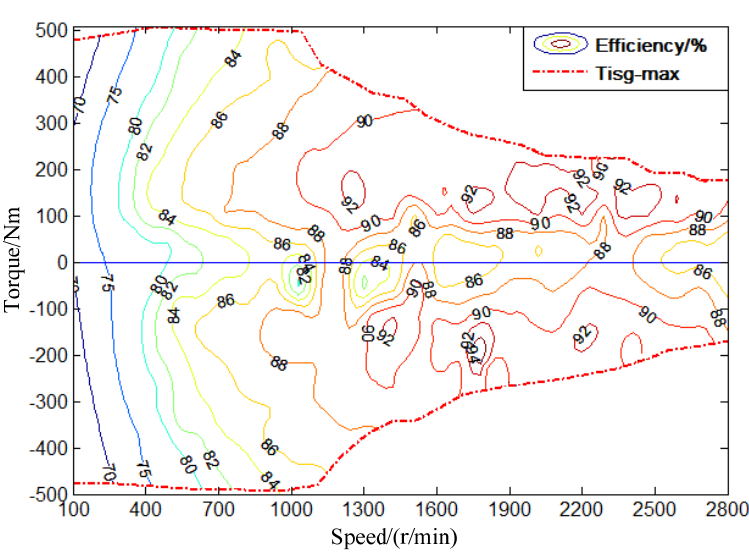
Figure 5. The ISG efficiency map.